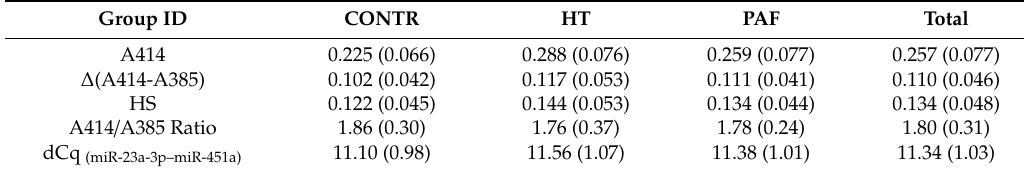
Characteristics of hemolysis assessment in the study sample groups: PAF: 30 PAF patients; HT: 30 hypertensive patients without AF; CONTR: 30 healthy controls. A414 and A385: spectrophotometric absorbance at 414 and 385 nm wavelengths obtained during hemolysis assessment, respectively; HS: hemolysis score; dCq (miR-23a-3p–miR-451a) : Cq di ff erence between miR-23a-3p and